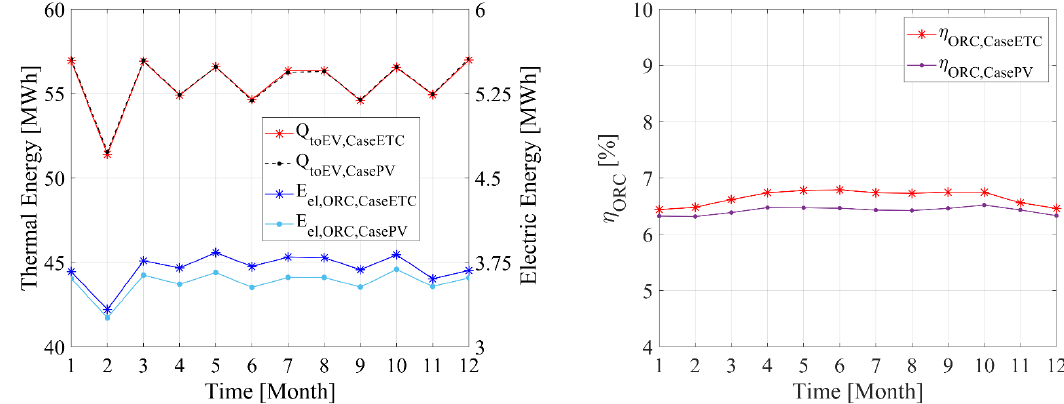
ffi ciency ( right